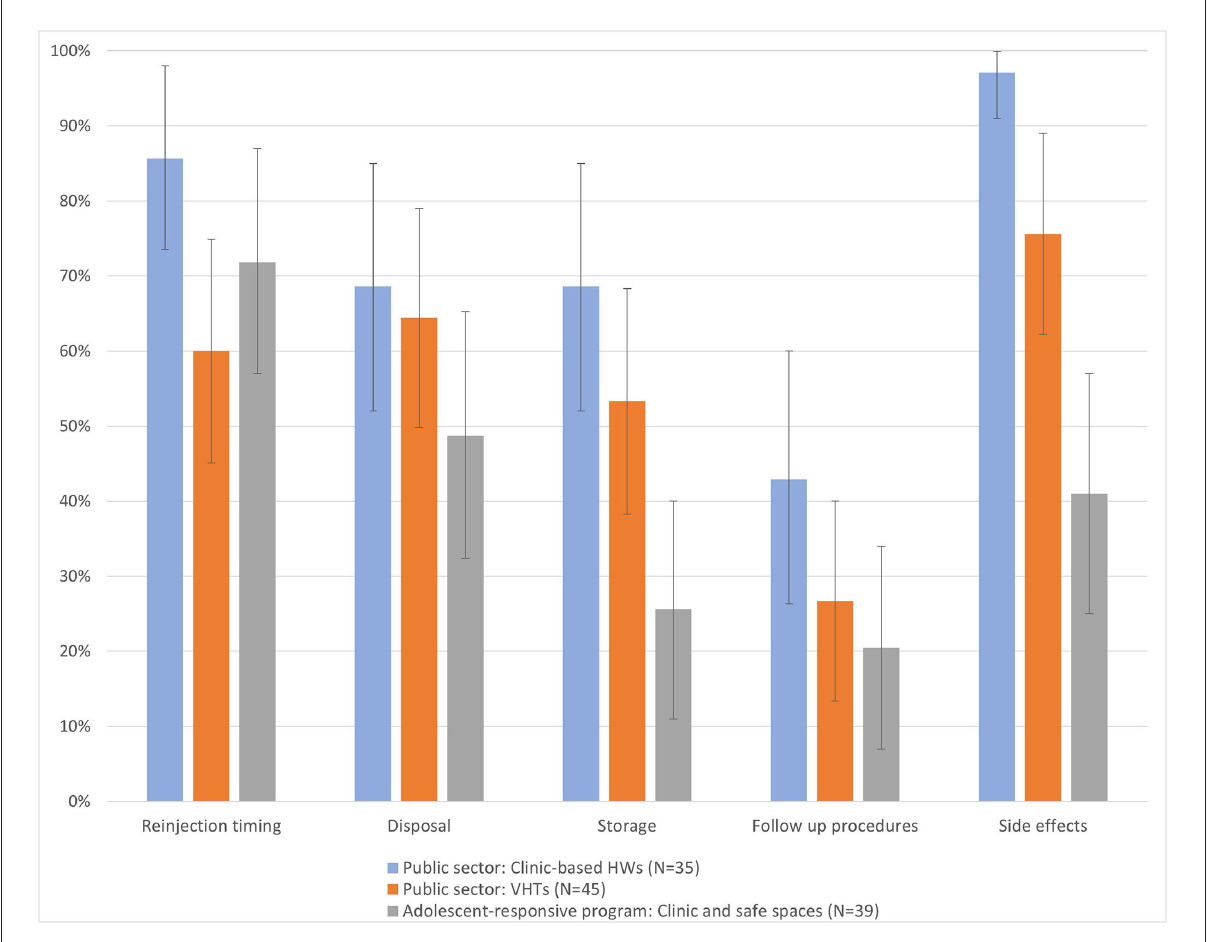
FIGURE1 Self-injection topics discussed by health workers during client training.